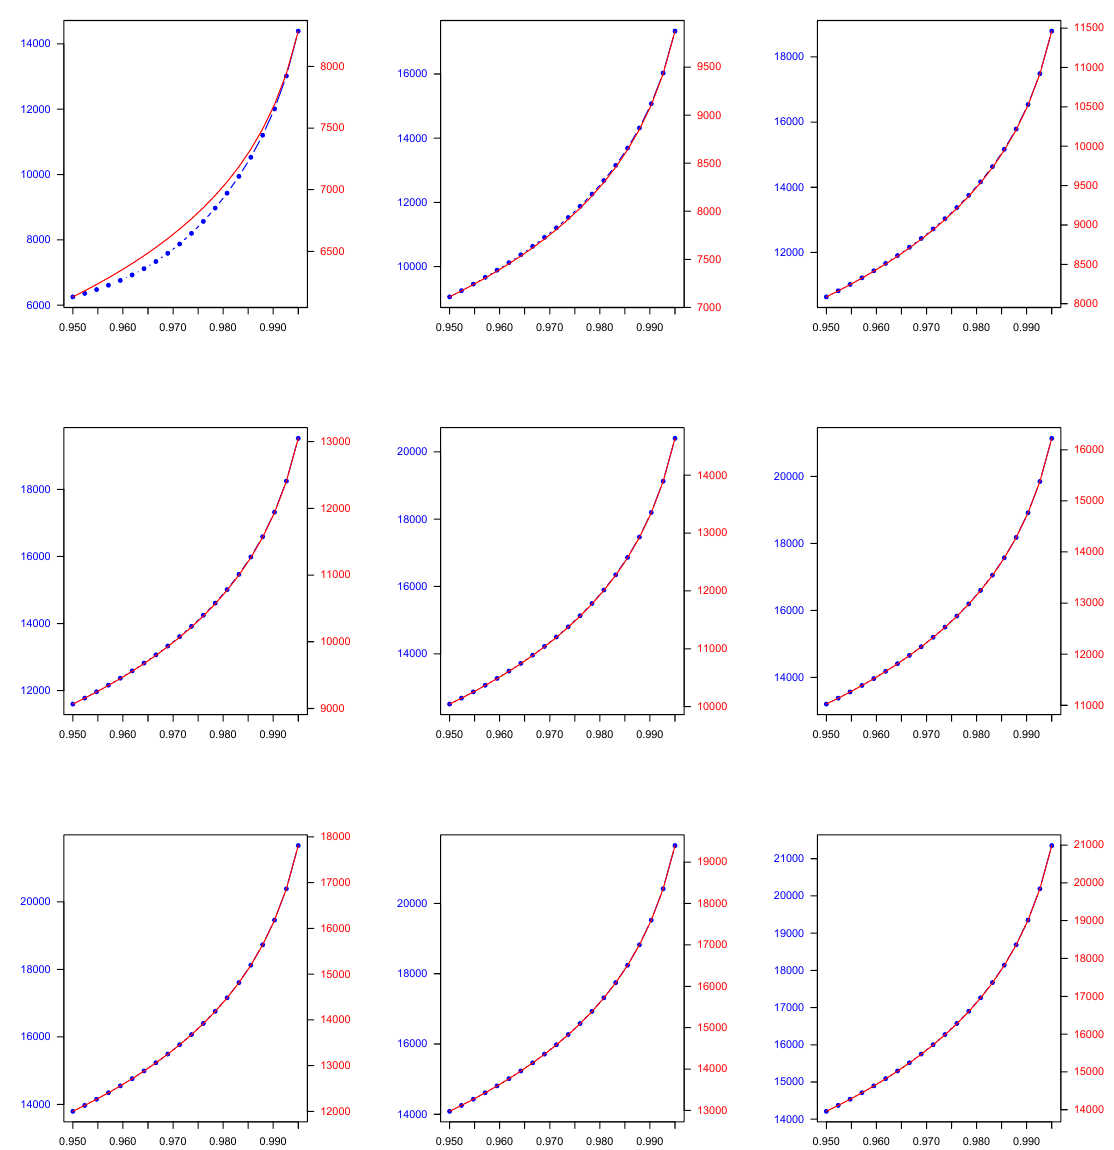
Figure 3. Two-Component (2C) Gamma finite mixture model-based (1 − α ) quantile Q mix . (blue colour) across all ( ˆ π 1 , ˆ π 2 ) combinations versus two-component (2C) Gamma weighted average-based (1 − α ) quantile Q w . a . (red colour) across all ( π 1 , π 2 ) combinations, where (1 − α ) takes values in the range of 0.950-0.995. Note that, due to a considerable discrepancy between Q mix . and Q w . a . values, each given plot has two different y axes—one for each quantile